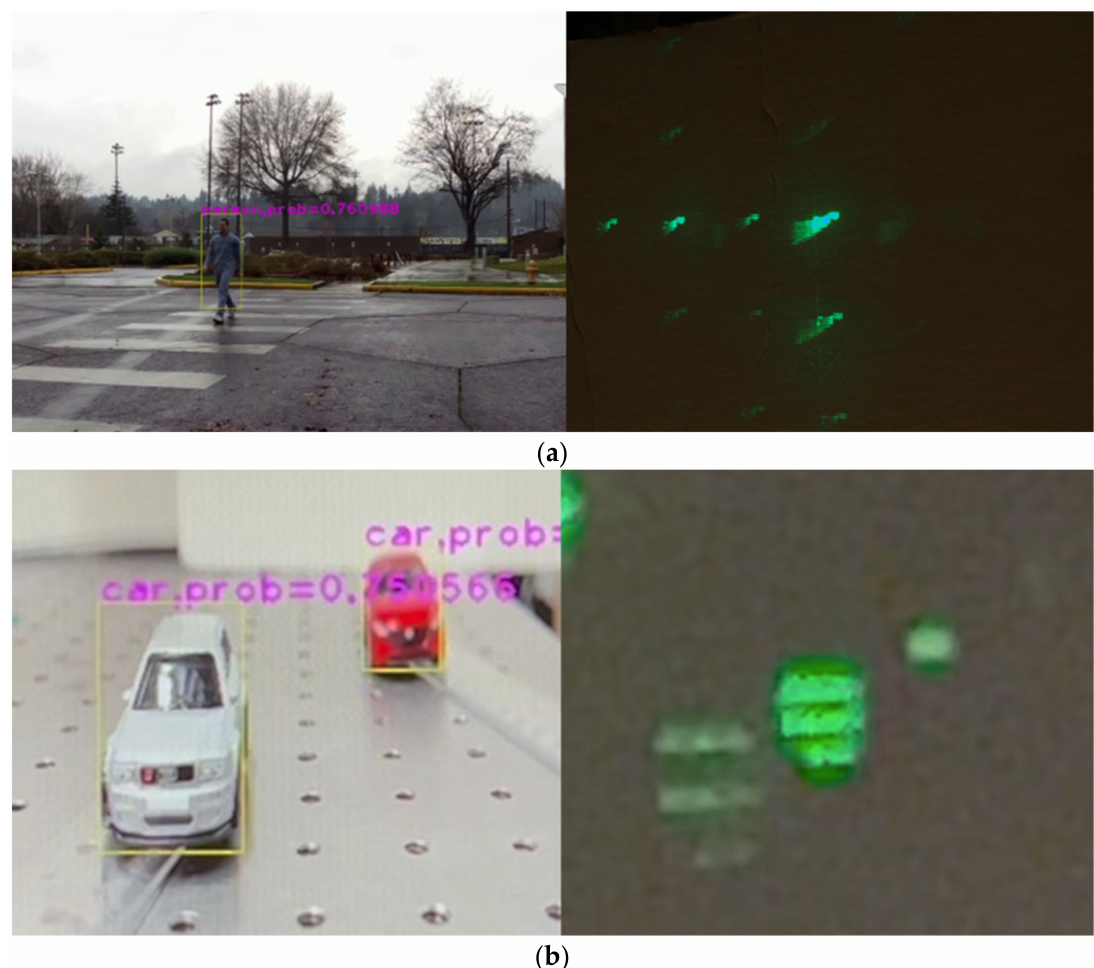
Figure 7. Adaptive single-beam steering demo. The USB camera captures the image of ( a ) a pedestrian crossing the street on an LCD screen. The TI-PLM scans through the man as he is moving. See Video S4. ( b ) Two miniature cars captured by a USB camera. A distant (smaller in appearance) car is beam. See Video